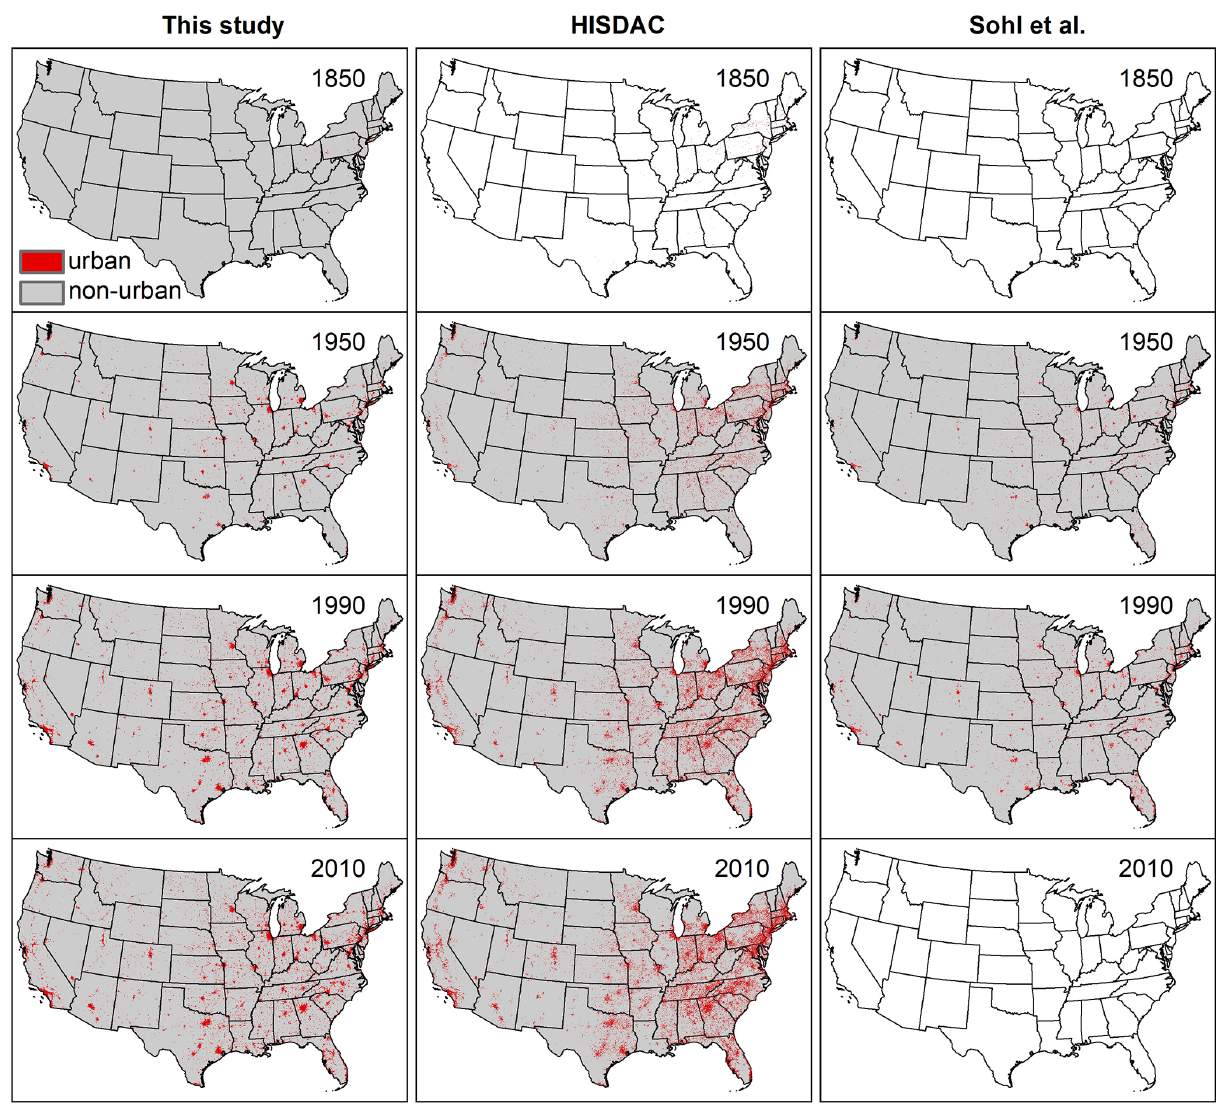
Figure 13. Comparison of urban land maps among three datasets for the conterminous United States: this study (left column), Historical Settlement Data Compilation (HISDAC) map (central column), and Sohl et al. (2016) map (right